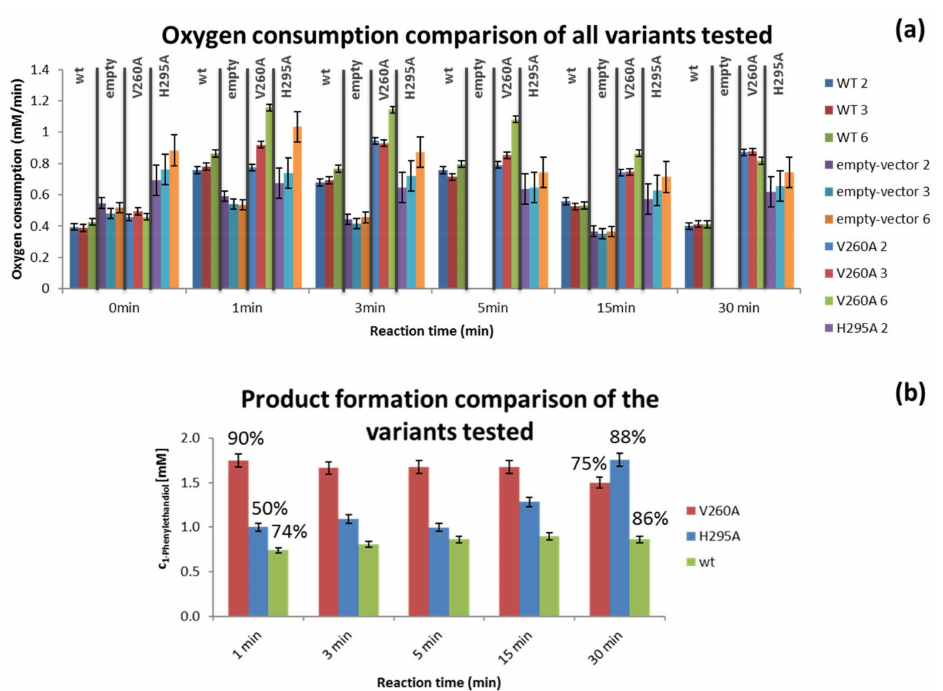
Figure 7. Oxygen consumption rate values for all the cell types tested with the pulling sample approach and higher cell concentration ( a ) and GC results for the two variant containing cells (at 2 mM styrene) and wt cells (at 1 mM) of 1-phenylethanediol concentration produced during the reaction and percentage of substrate conversion obtained at 1 and 30 min of residence time ( b